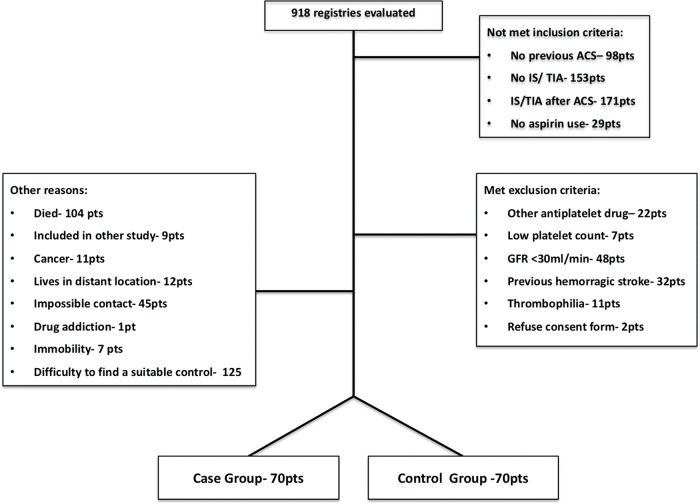
Inclusion Flowchart. ACS- acute coronary syndrome, IS- ischemic stroke, TIA- transient ischemic attack, GFR- glomerular filtration rate, pts- patients.